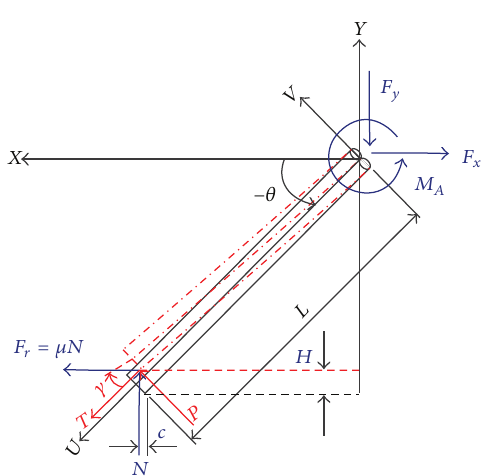
Figure 4: Free body diagram of the polishing